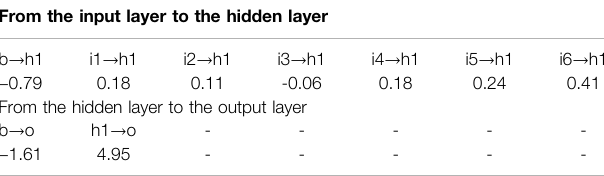
TABLE 6 | Connection weights and biases of hidden and output layers of the N6- 1-1 model.